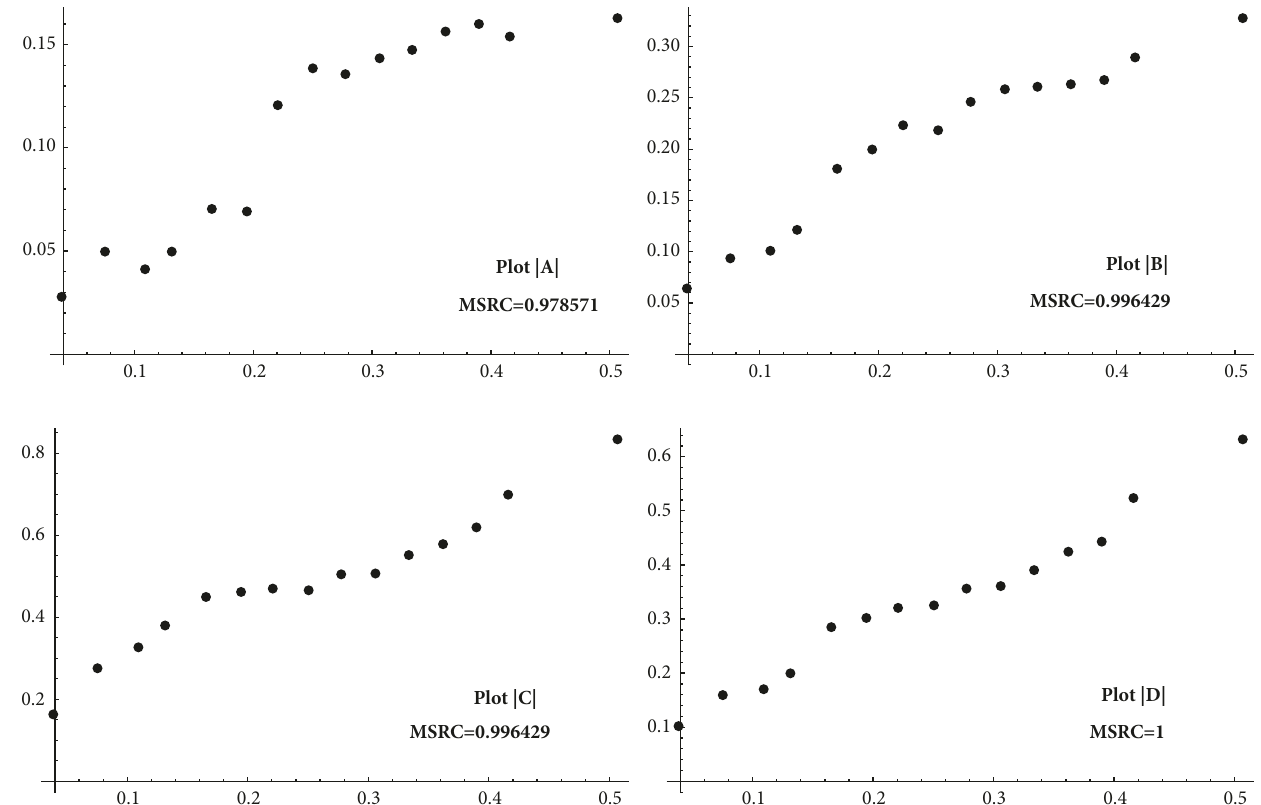
Figure 4: Performance of the new PCM-CM: TSL ( A ) . The plots present the relation between a mean value of TSL ( A ) within a given interval (VRCM n ) and quantiles of order 0.1 (Plot A), 0.5 (Plot B), and 0.9 (Plot C) of MREs distribution as well as MREs average values (Plot D) for estimated and true PVs. The results were generated with application of LLSM as the PP and geometric scale. Plots are based on 10,000 random reciprocal PCMs for n